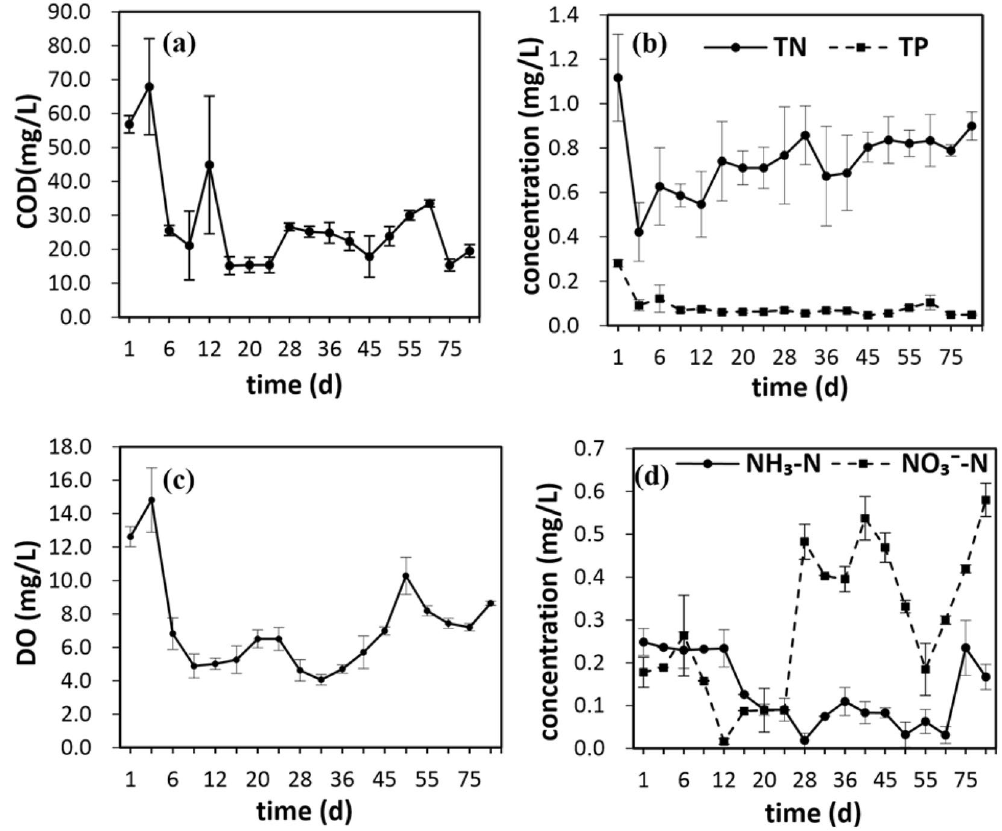
Figure 3. Variation of water quality ( a : COD; b : TN and TP; c : DO; d : Ammonia and nitrate) of study water body during 90 days’ EAS